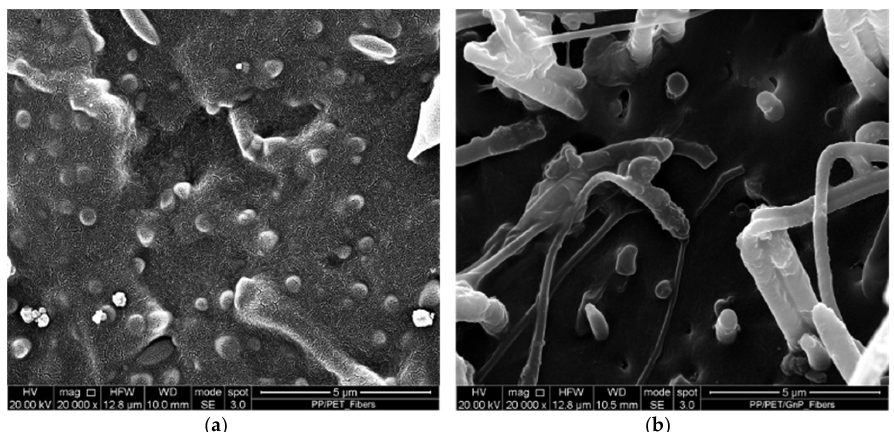
Figure 7. SEM micrograph of fibers of the blend ( a ) and the nanocomposite ( b ).